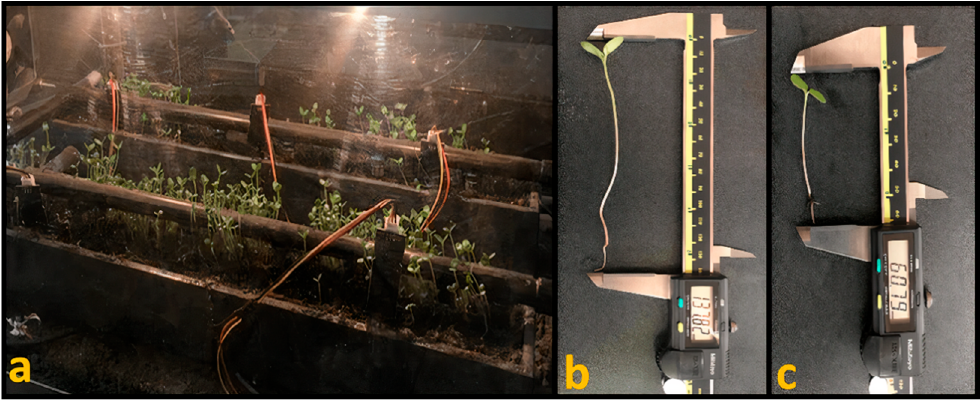
Figure 7. Sprout production in micro-greenhouse ( a ). Larger sprouts collected in micro-greenhouse ( b ) in contrast with traditional technique ( c ).